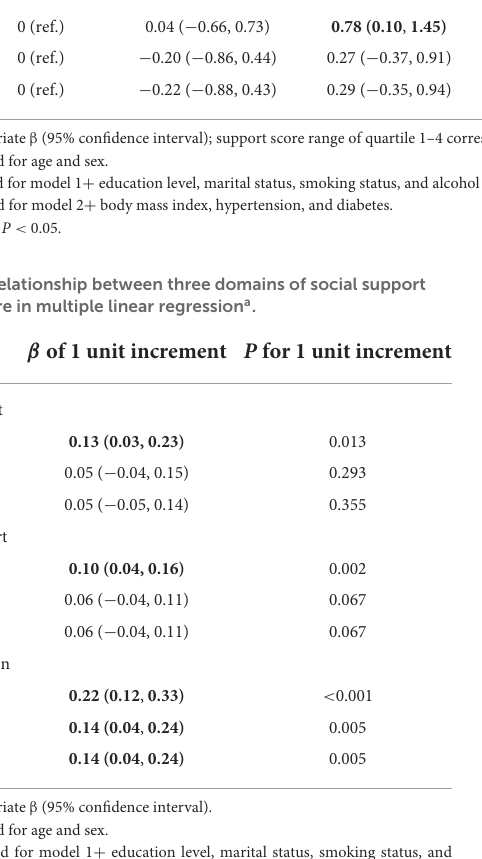
d Model3:adjustedformodel2 + bodymassindex,hypertension,anddiabetes. Boldvaluesmeans P <